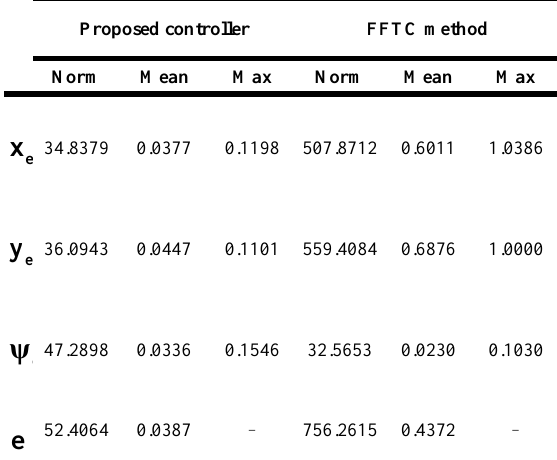
Table 1. Comparison of tracking errors between the proposed and FFTC methods after 30